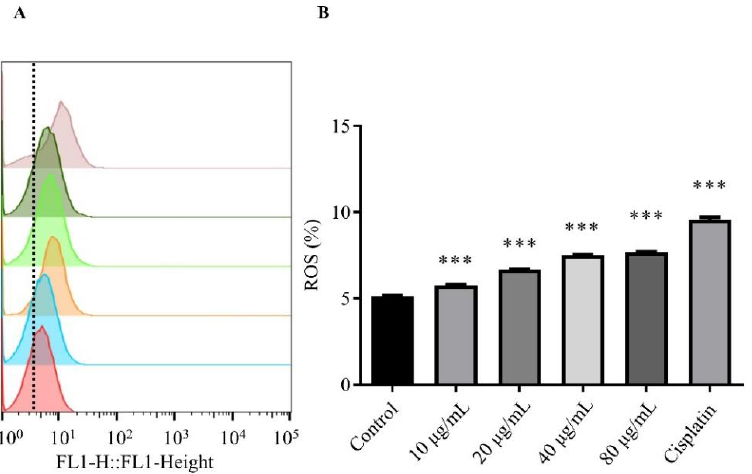
Figure 5. Effect of HSF on ROS levels in MCF-7 cells. ROS levels were measured using DCFH-DA staining via flow cytometry. The images from bottom to top indicate the control group, 10, 20, 40, and 80 µ g/mL, and the positive drug group. ( A ) Flow cytometry for analysis of cellular ROS levels. ( B ) ROS%. *** p < 0.001 vs. control group.